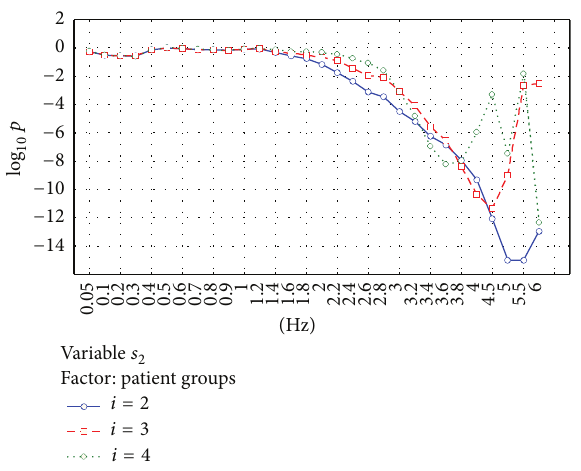
Figure 5: Analysis of the parameter 𝑠 2 . The figure shows the statistical significance 𝑝 of the main effect in MANOVA analysis for the factor “patient groups.” Logarithmic scale is used. Starting from about 2.4 Hz, an increase in the filter frequency causes the increase in the ability of 𝑠 2 to separate different age groups. While building PCA matrix, the use of 𝑖 = 2 gives relative best results.